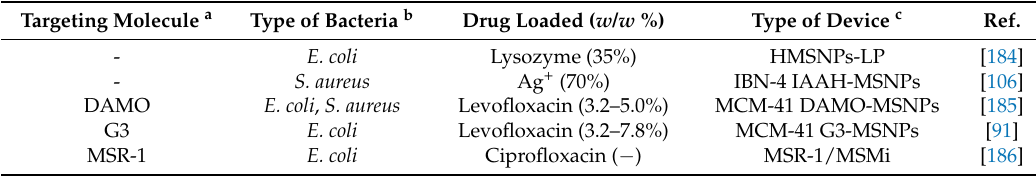
Table 5. Mesoporous Silica Nanoparticles for the Treatment of the Formed Biofilm.